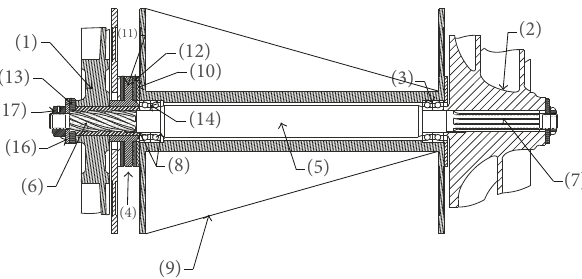
Figure 2: Section of the micro-GT support system assembly designed according to the invention.